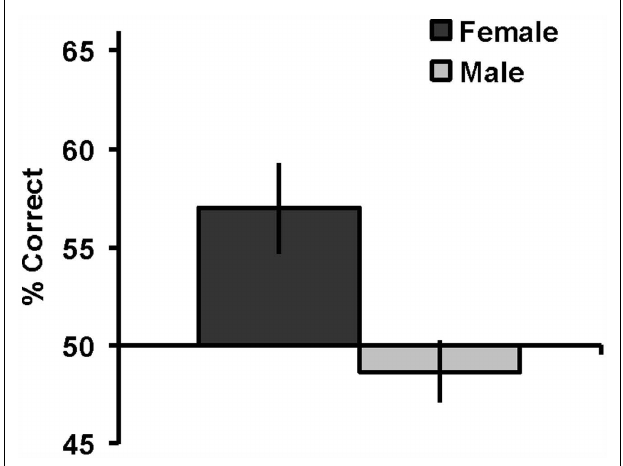
FIGURE 7 | Examples of composite celebrity images (JenniferAniston andAngelina Jolie), the androgynous celebrity composite used for transforming and as a probe face, and male versions of the antifaces used as adapting stimuli. Antifaces here are created by transforming the original face through the androgynous average face –